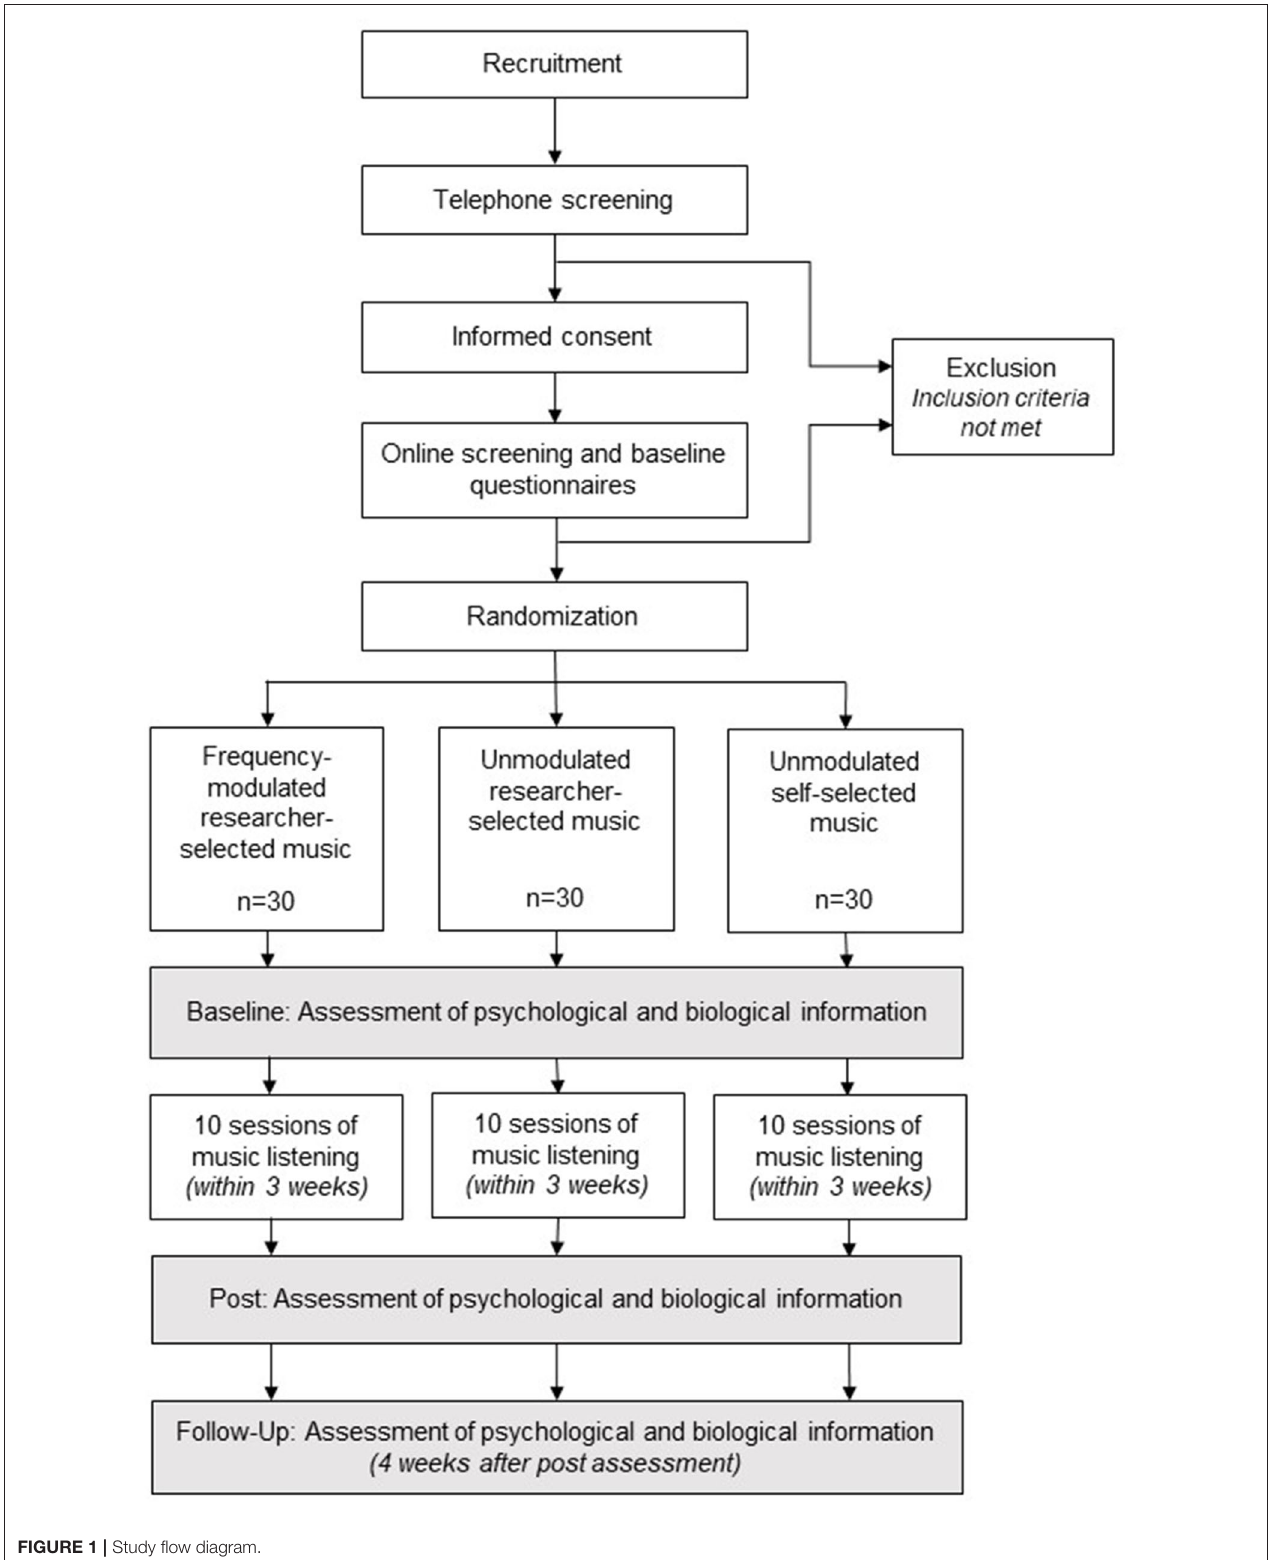
FIGURE 1 | Study flow